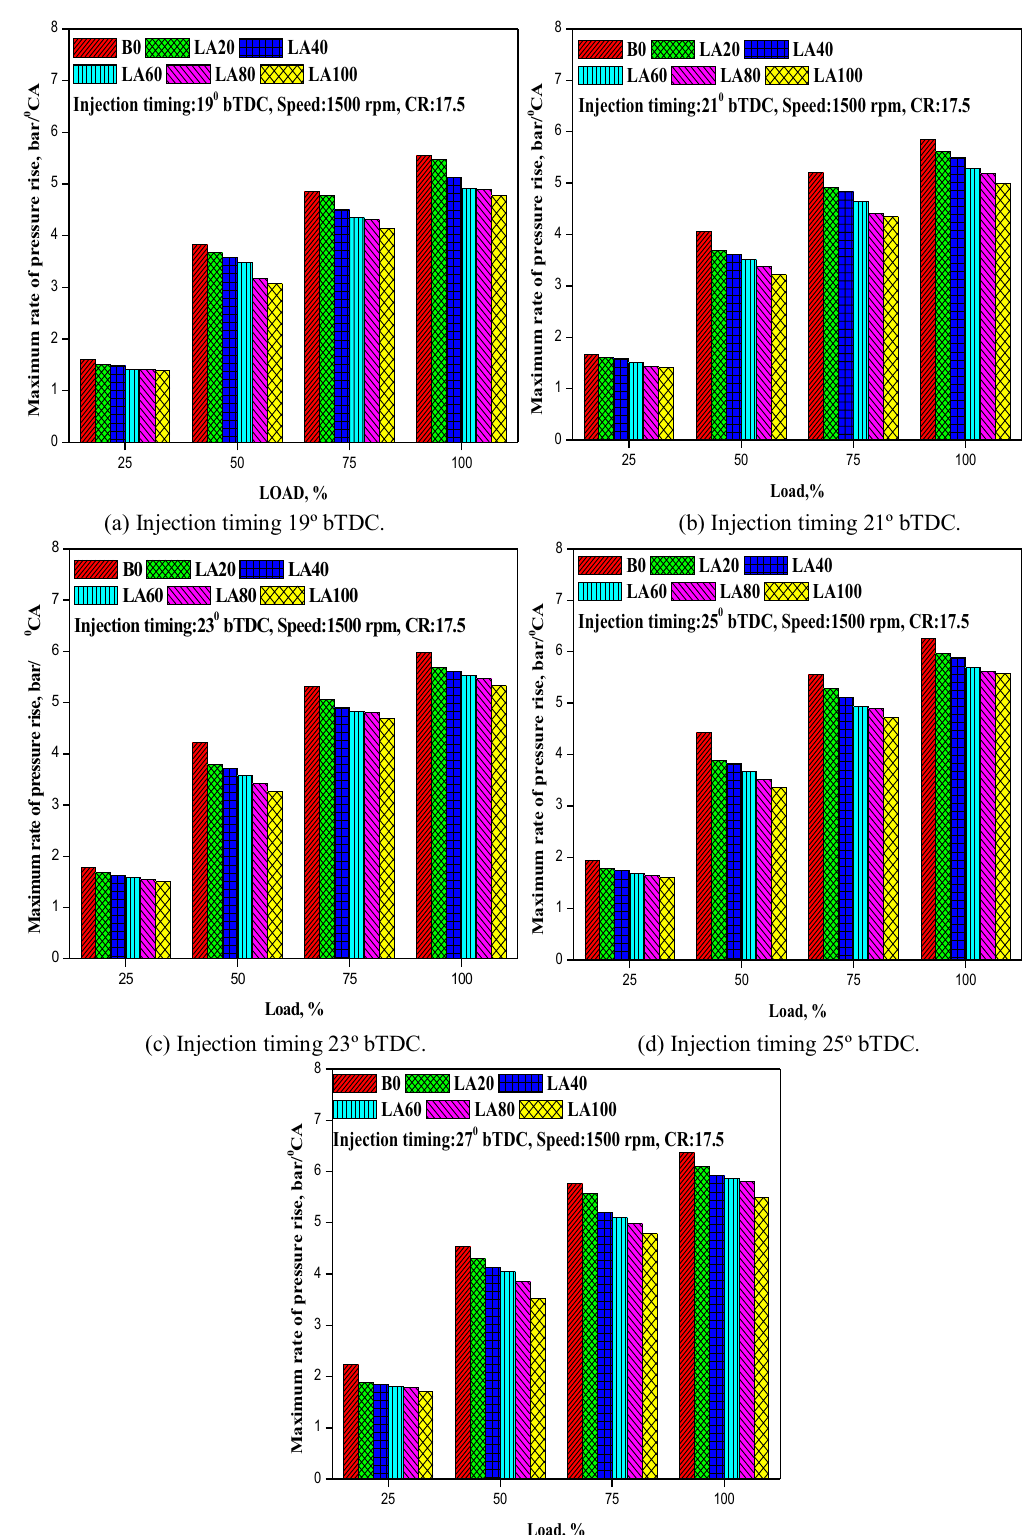
Figure 10. ( a–e ) The variation in MRPR with different FITs and engine load for considered fuel